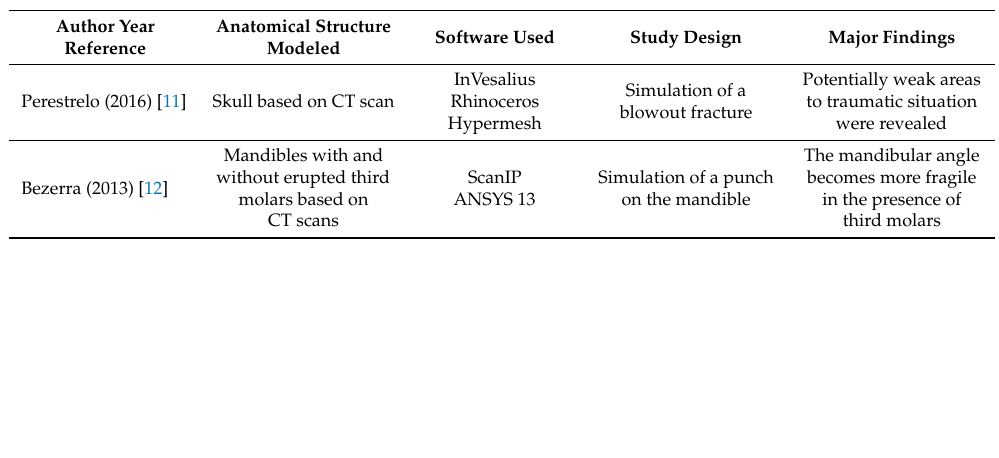
Table 1. Information regarding FEA conducted in the field of trauma